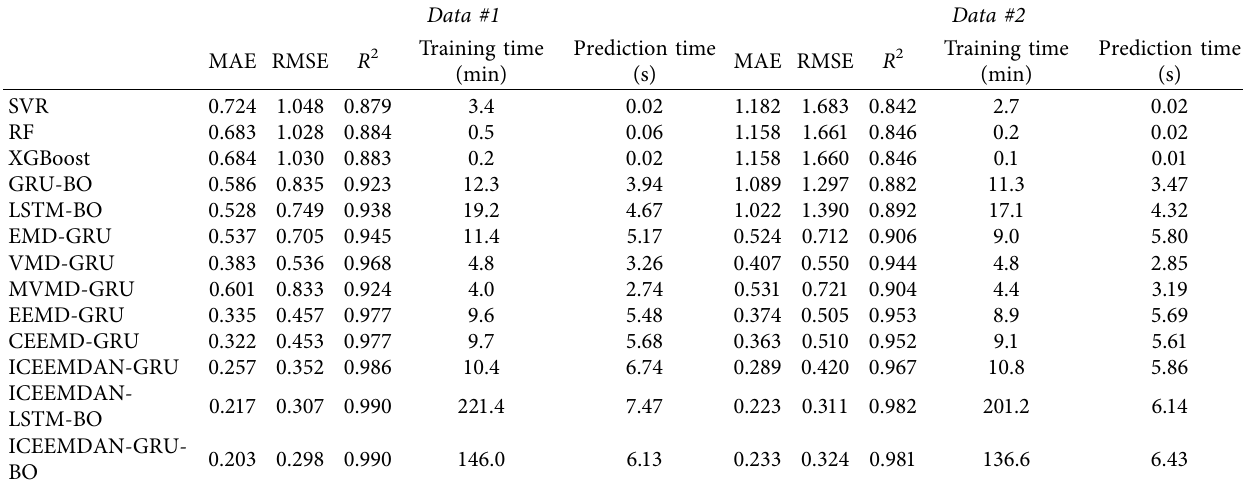
Table 6: Performance comparison of diferent prediction models.